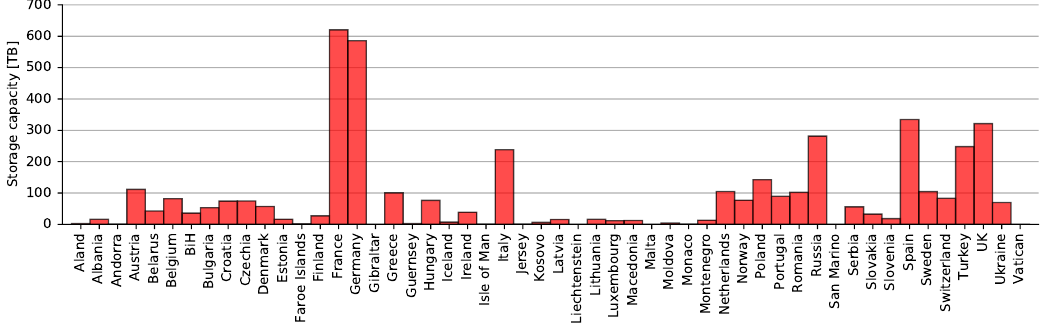
Figure 21. Storage required for storing images for individual countries/territories with Imperx